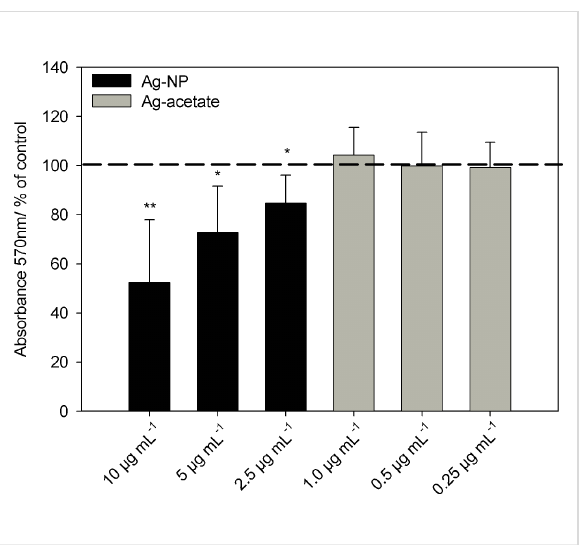
Figure 7: Influence of Ag-NP/Ag + ions on the osteogenic differenti- ation of hMSCs after 21 d of incubation. Quantitative analyses of mineralization were performed by measuring the optical density (570 nm) of extracted alizarin red S. The data are expressed as the mean ± SD ( n = 3 independent experiments), given as the percentage of cells cultured under osteogenic conditions in the absence of silver. The asterisks (*) indicate significant differences with respect to to the control (* p < 0.05; ** p < 0.005).